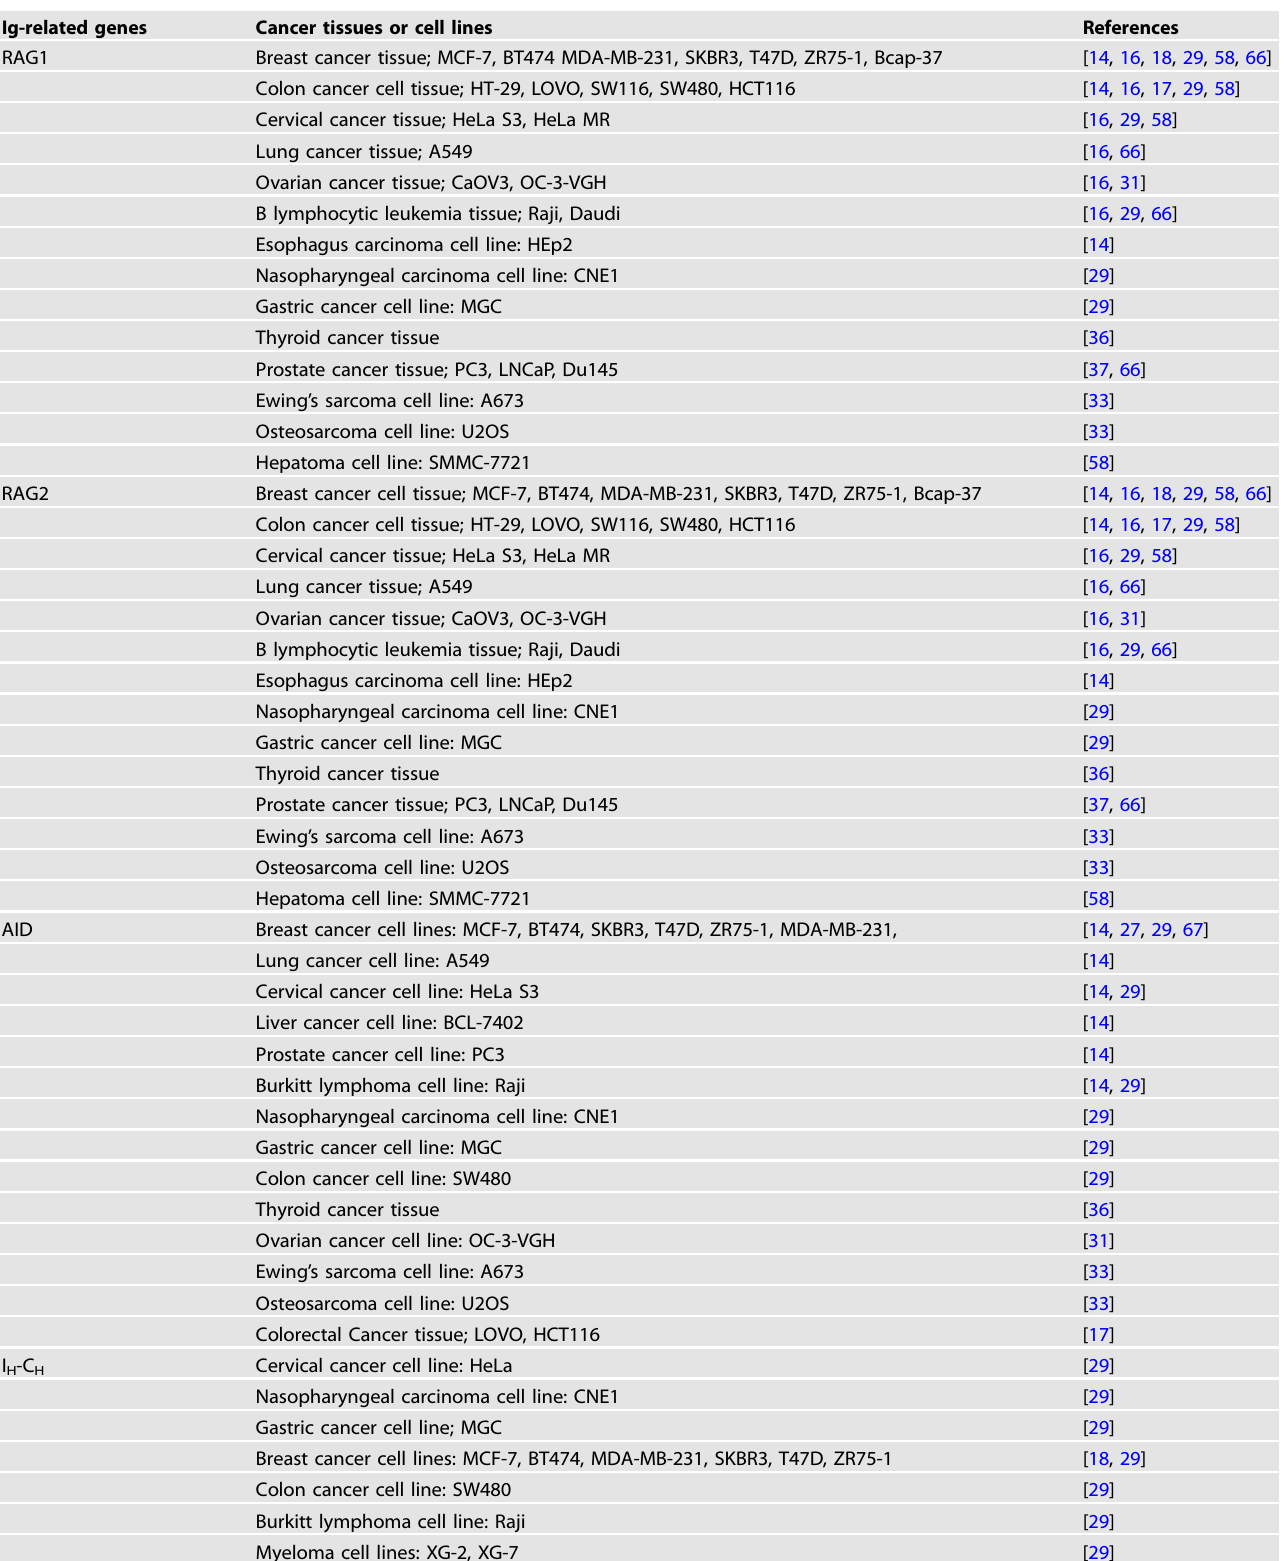
Table 2. List of tumor tissues and cell lines expressing Ig-related genes. Ig-related